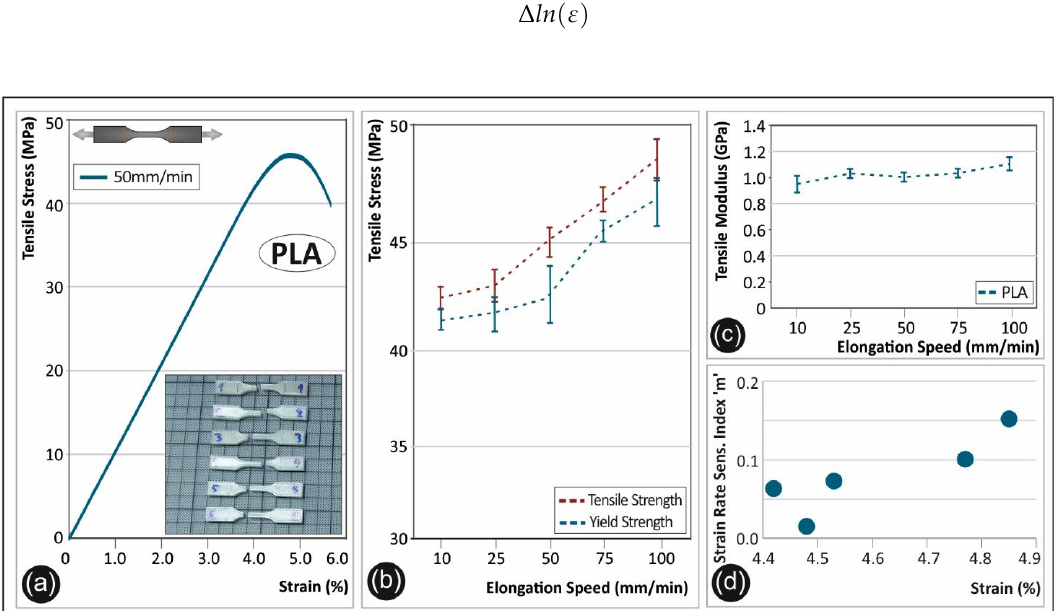
Figure 2. ( a ) Representative tensile stress (MPa)—strain (%) curve of polylactic acid (PLA) at a 50 mm/min elongation speed, ( b ) average tensile strength and yield strength (with the corresponding standard deviation) for PLA in all five elongation speeds, ( c ) tensile modulus (with the corresponding standard deviation) of PLA under the five different elongation speeds, and ( d ) strain rate sensitivity index “m”—strain (%) graph for PLA.